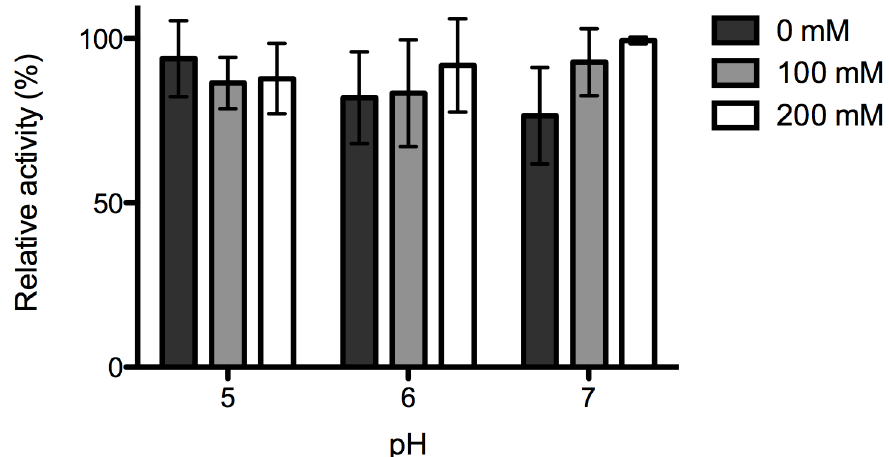
Fig 2. Effect of ionic strength on PlyPl23 lytic activity. PlyPl23 activity on P . larvae Pl02-23 at different pH values (pH 5.0, 6.0, and 7.0) supplemented with 0, 100 and 200 mM NaCl. Relative lytic activity was obtained as the ratio between the lytic activity of each test and the highest value obtained (the reference value was 50.4% lytic activity). Each column represents the mean of triplicate experiments and error bars indicate the standard deviation.